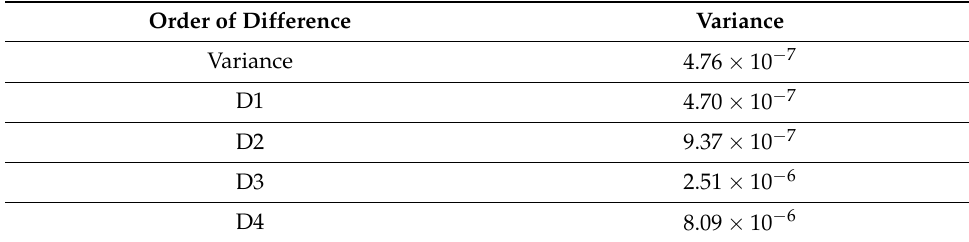
Table 4. Variance value at a different order of Figure 11. Signal filtration using back-propagation neural network.